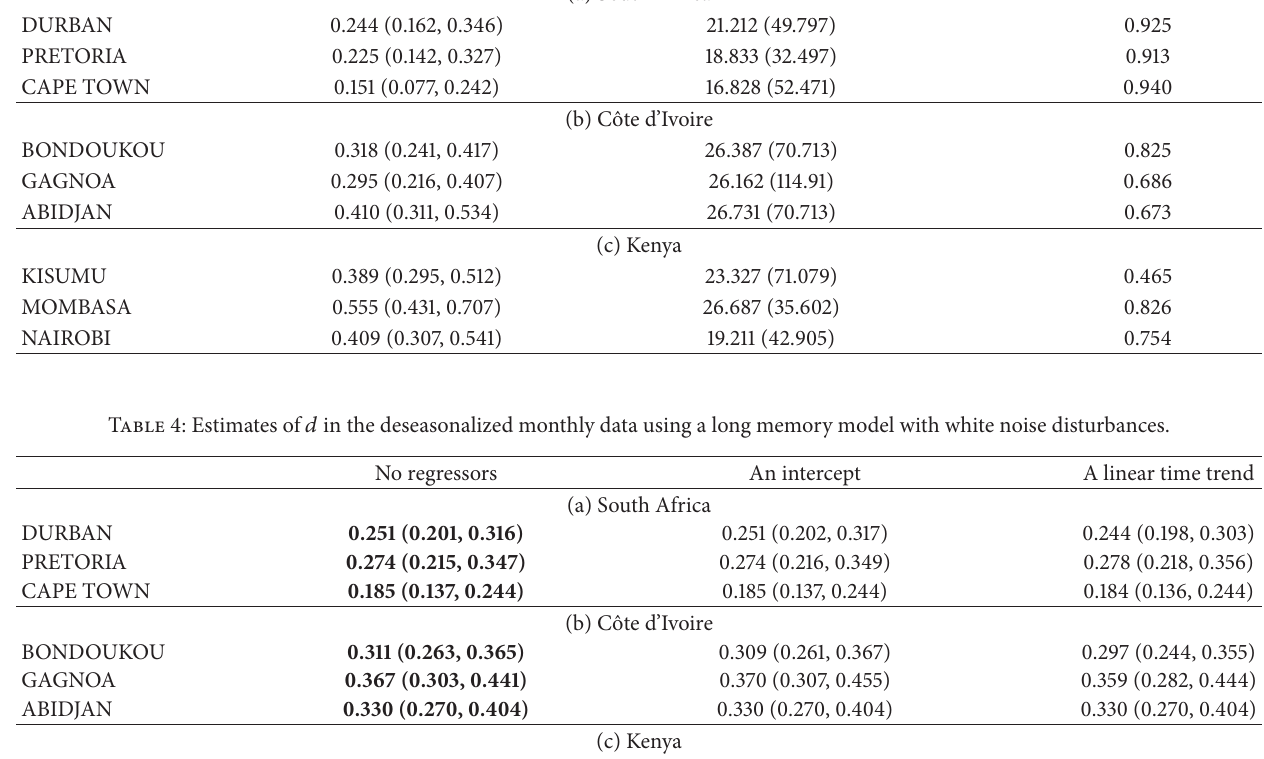
Table 5 imposes an AR(1) structure for the 𝐼(0) error term 𝑢 𝑡 . Starting with the results with uncorrelated errors (in Table